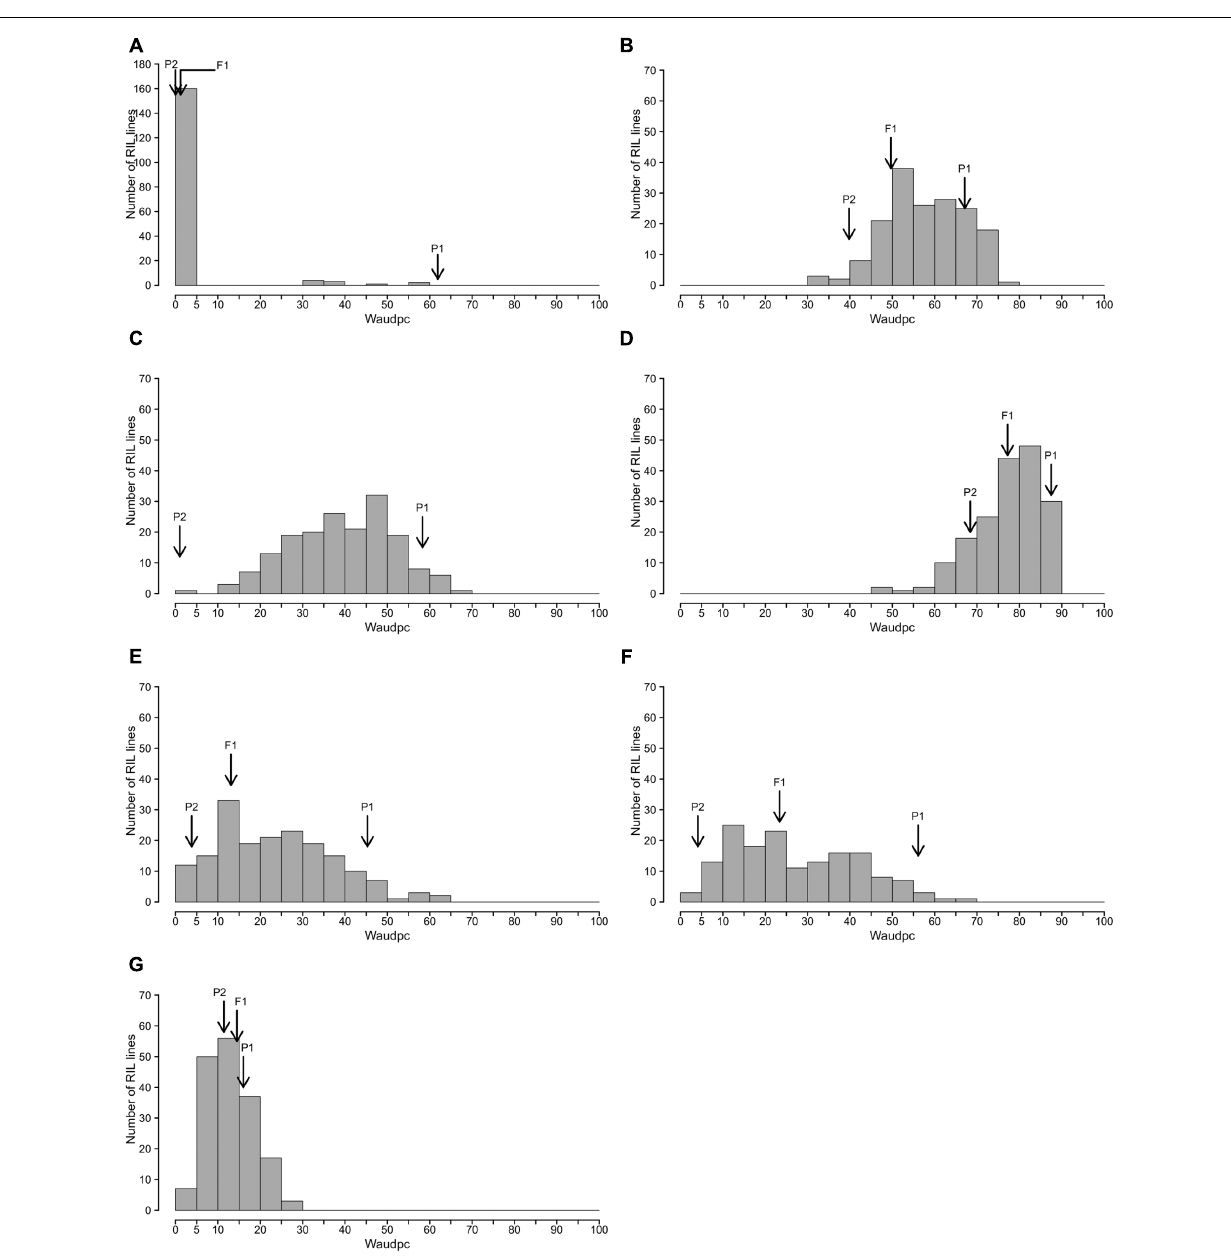
FIGURE 2 | Frequency distributions of Waudpc in the eggplant [MM738 × AG91-25] RIL population, inoculated with eight R. solanacearum species complex strains. Frequency distribution of Waudpc (area under the disease progress curve, based on the progressive percentage of wilted plants) for strains GMI1000, CMR134, and PSS366 combined in a single analysis (A) ; combined seasons for strain PSS4 (B) ; TO10.Indonesia (C) T010.Réunion (D) ; and combined seasons for strains CFBP2957 (E) , CFBP3059 (F) and CMR34 (G) ; Arrows indicate the means of susceptible parent P1 (MM738), resistant parent P2 (AG91-25) and their F1 (P1 ×